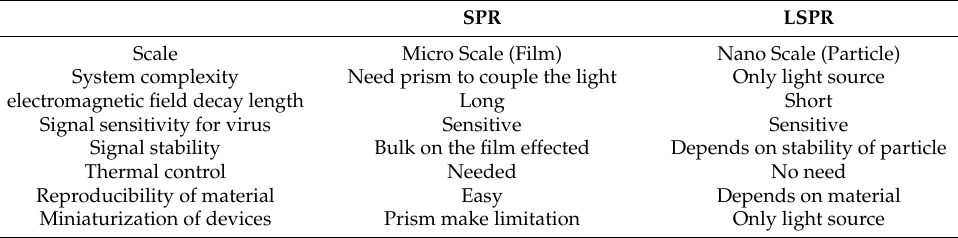
Table 3. Differences between SPR and LSPR in virus detection technology